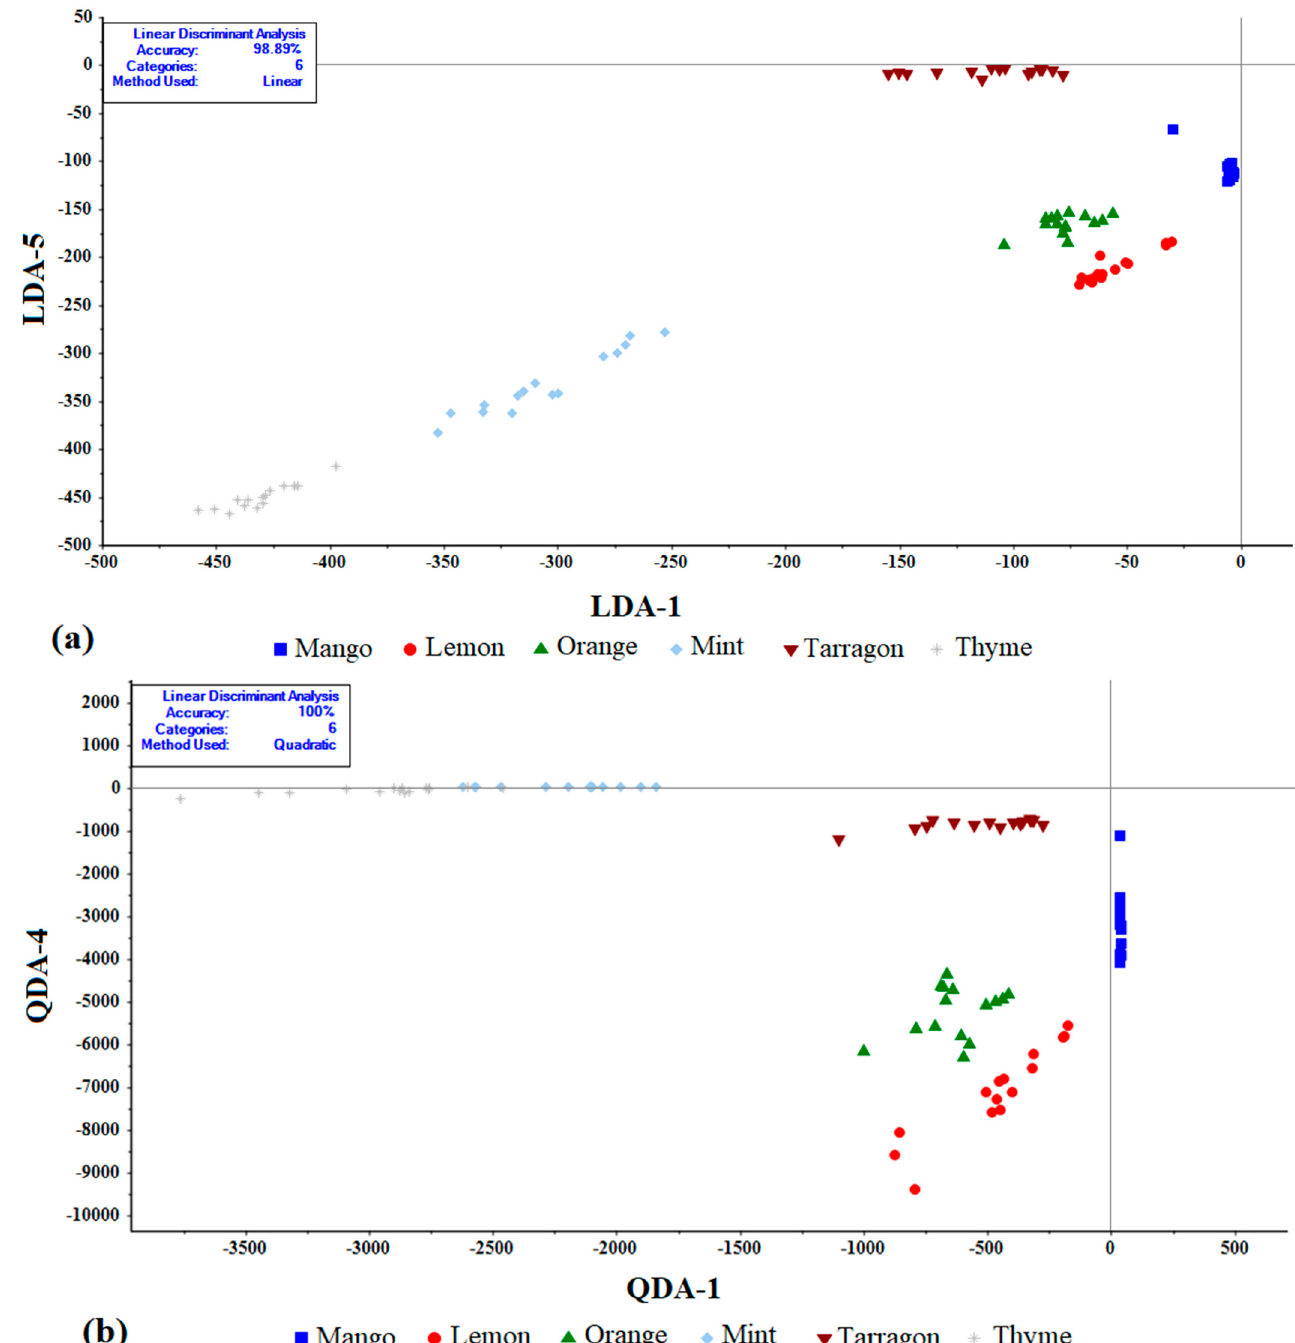
Figure 6. Classification of edible essential oils using two statistical methods: ( a ) LDA and ( b ) QDA methods. The confusion matrix and performance parameters of LDA and QDA methods for classifying all essential oils are presented in Tables 3 and 4. According to the results of Table 4, the accuracy of data classification using LDA methods was 98% and the accuracy of QDA method was 100%.